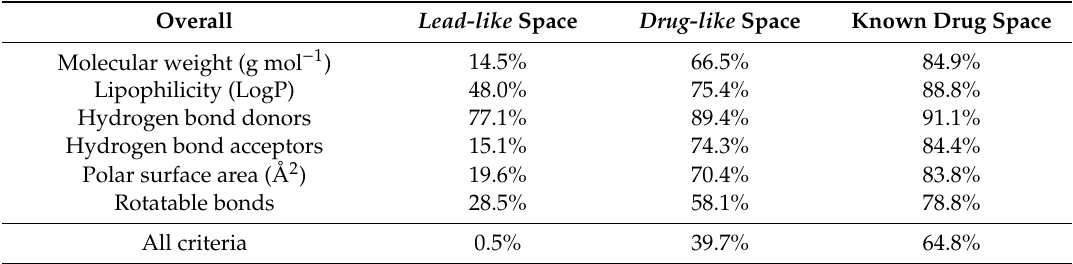
Table 3. All compounds in this study and their inclusion within the defined chemical